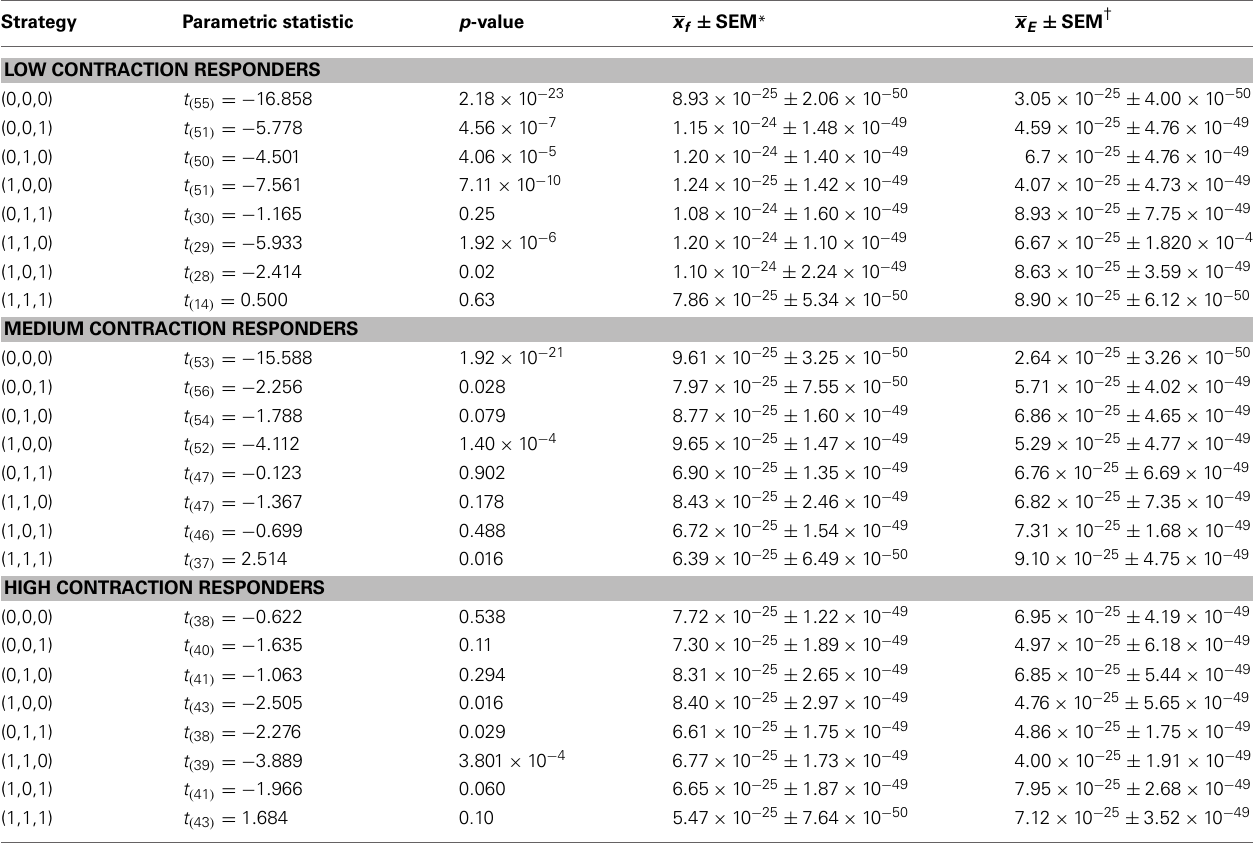
Table 1 | Comparisons of contraction Boltzmann entropies to bit-flip error thresholds. Strategy Parametric statistic p -value